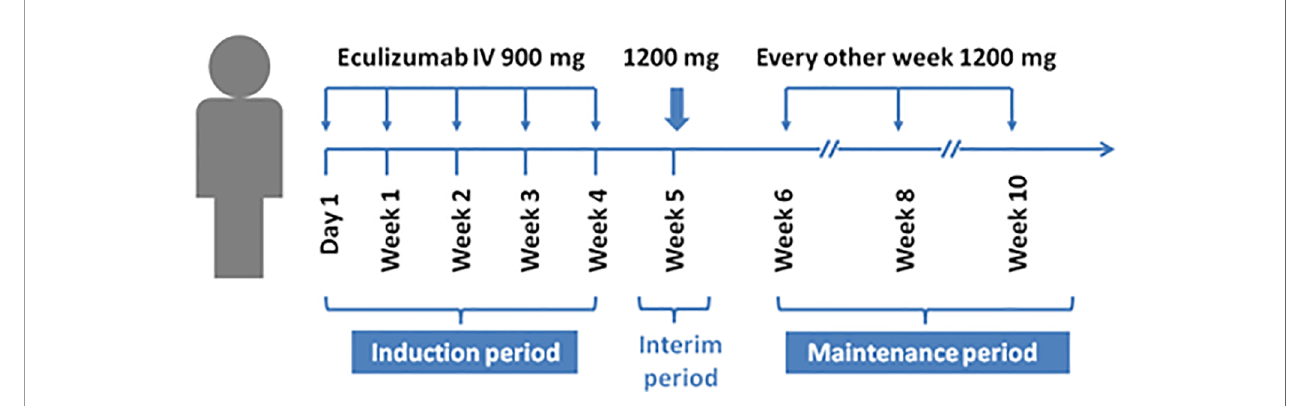
FIGURE 2 | Clinical trials of eculizumab in patients with myasthenia